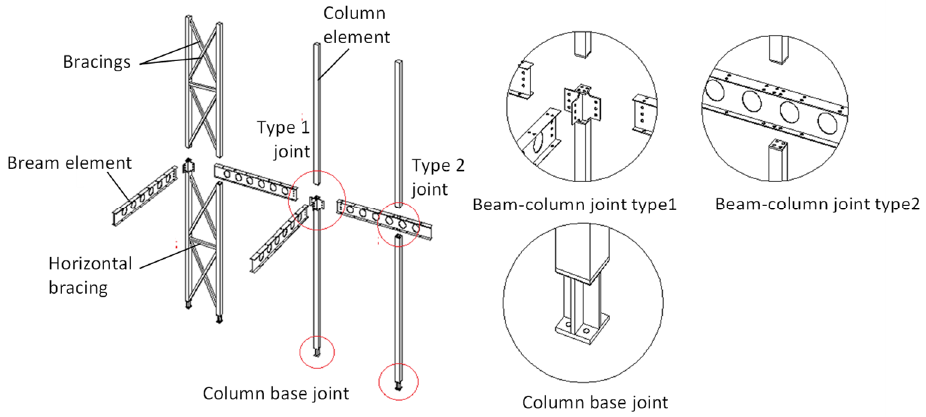
Figure 2. Schematic drawing of the structural system.